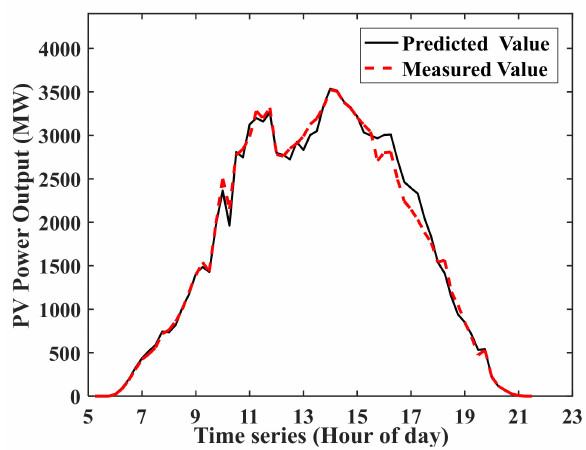
Figure 11. Regional output prediction.